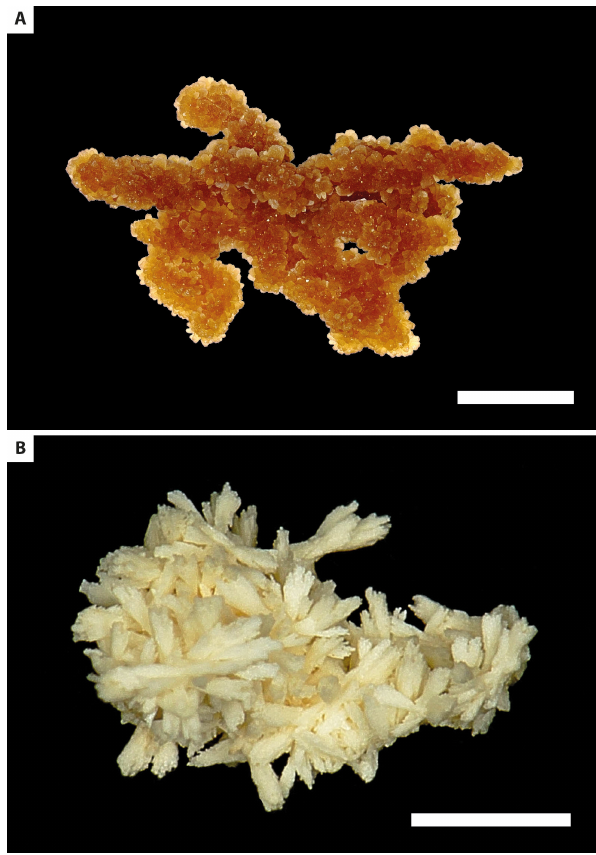
Figure 7. Morphology of cryogenic calcite crystals in normal re- flected light. (a) Typical brown crystal aggregate; sample MSK1. Scale bar 3mm. (b) White crystal aggregate; sample MSK5. Scale bar